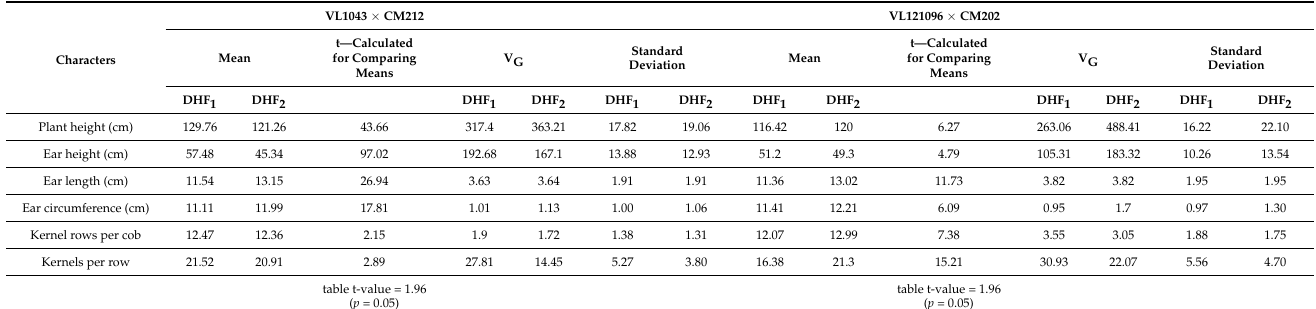
Table 7. Trait means and genetic variance (V G ) in doubled-haploid lines produced from F 1 and F 2 plants of crosses VL1043 × CM212 and VL121096 × CM202 for yield-related traits in maize.